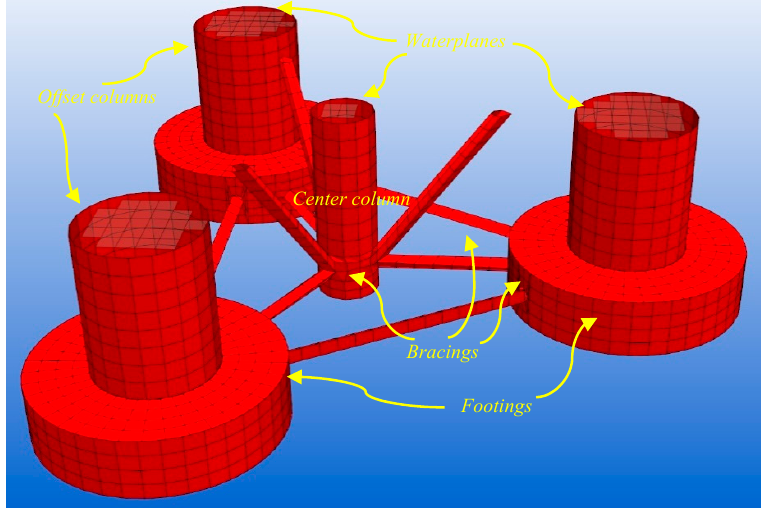
Figure 10. Hydrodynamic mesh of the immersed part of the OC4 DeepCwind floater, for use in HAMS and Hydrostar ®.